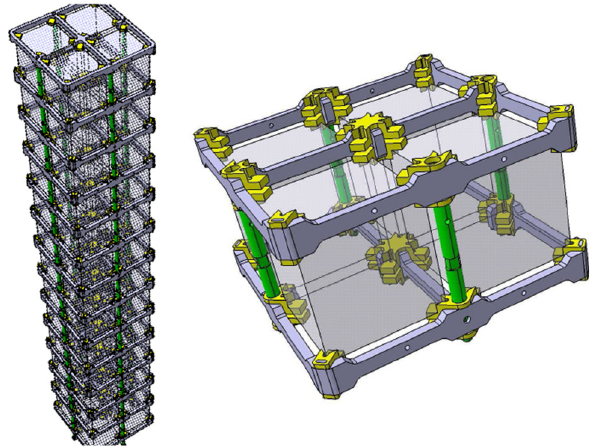
Fig. 1 Left one of the 19 CUORE towers. Right a 4-crystal plane. Two copper frames ( grey ) joined by four columns ( green ) form the mechanical structure that secures four crystals by means of polyte- trafluoroethylen (PTFE) supports ( yellow